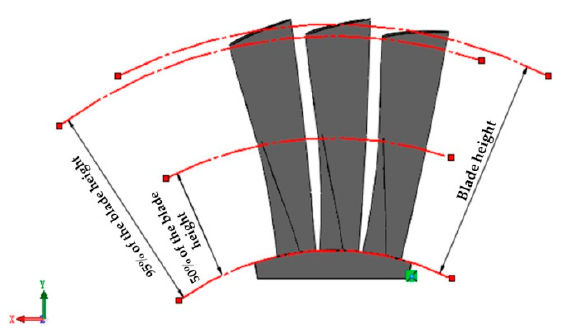
Figure 9. Two representative heights of the blade.